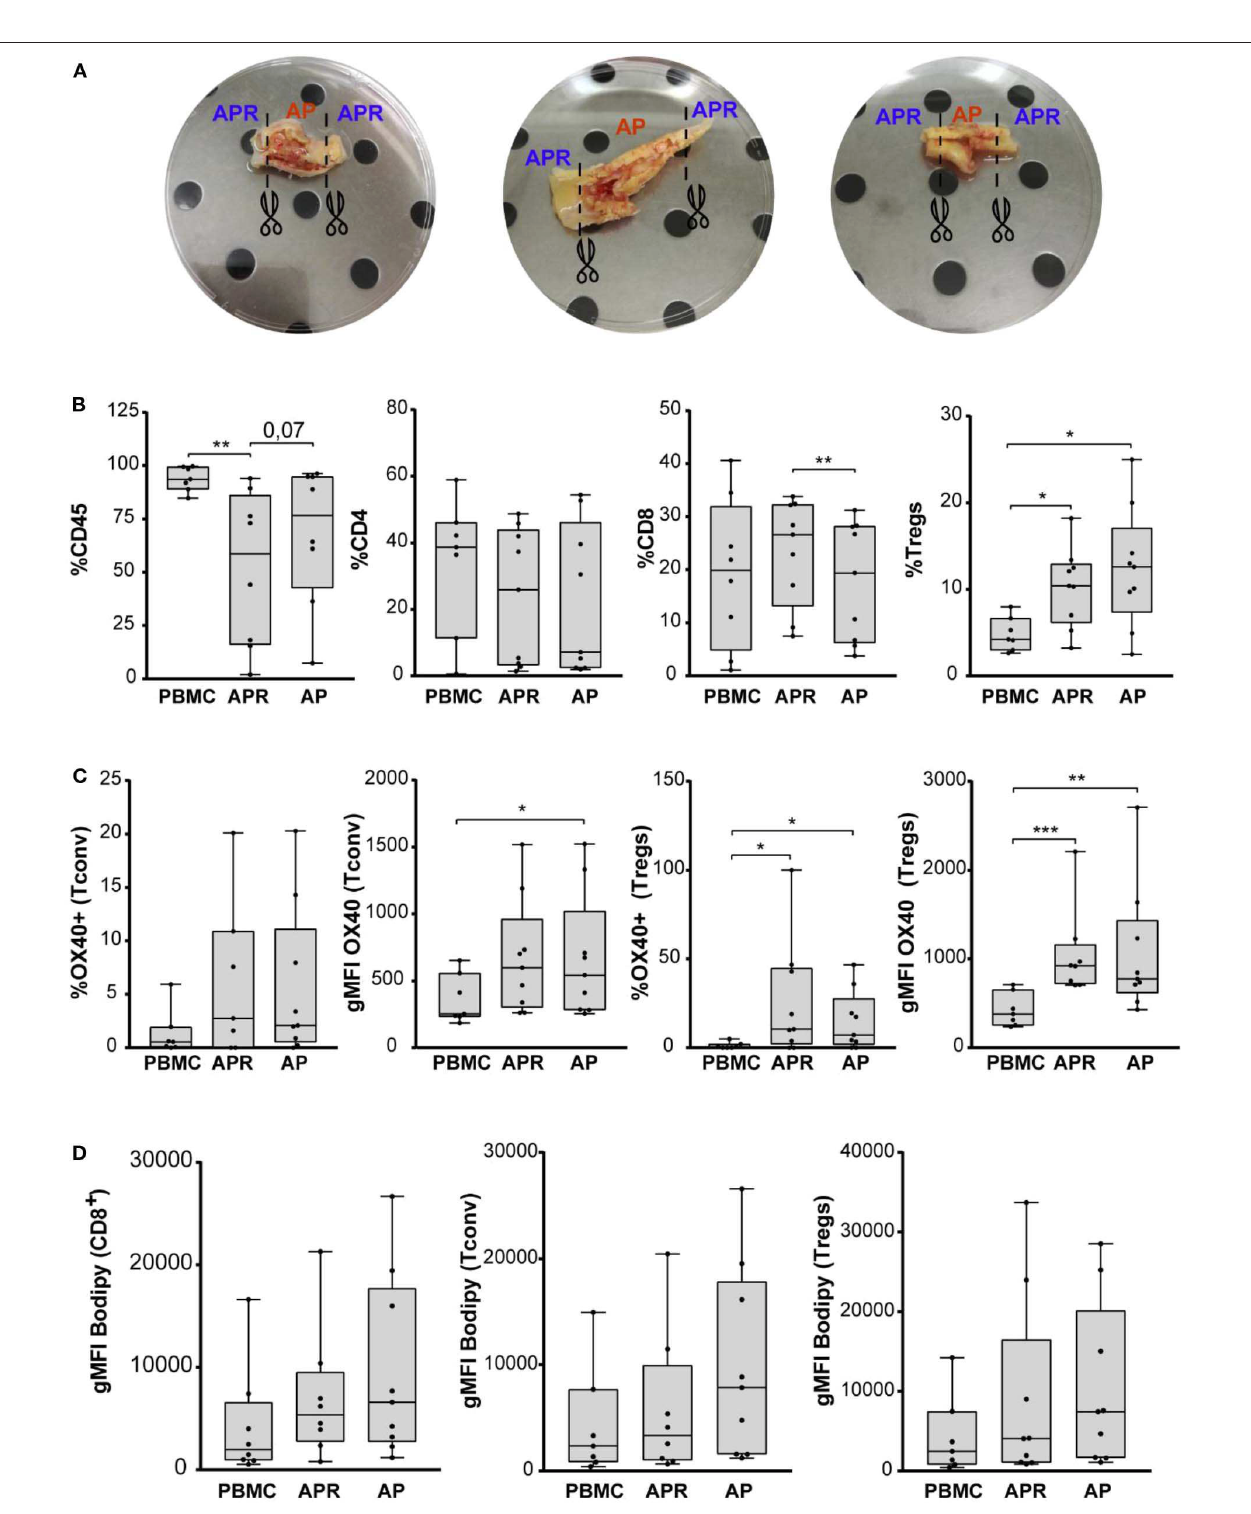
FIGURE 1 | (A) Three representative carotid endarterectomy samples. The image shows sample division strategy: APR (adjacent atherosclerotic plaque region), AP (atherosclerotic plaque). (B) Frequency of CD45, CD4, CD8, and Tregs (in gated CD4 + T cells) in PBMC, APR, and AP from CEA patients ( n = 9). (C) Percentage of OX40 in Tconv and Tregs and gMFI of OX40 gated on Tconv and Tregs. (D) gMFI of BODIPY in CD8, Tconv, and Tregs. In all figures, Tregs have been identified as FOXP3 + CD127 low within the CD14– CD8– viability dye– CD4 + CD25 + gate. * P < 0.05, ** P < 0.01, *** P < 0.001, by paired t -test, two-tailed.